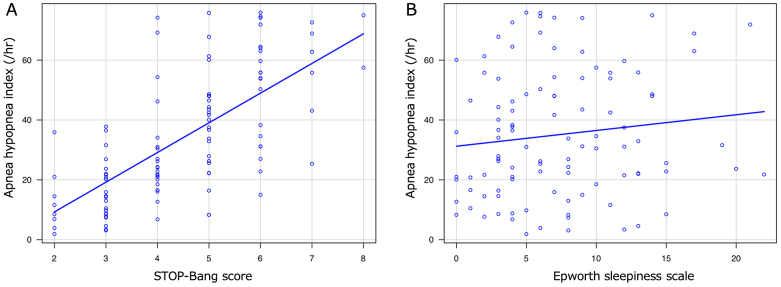
The correlation between the apnea hypopnea index (AHI) and the STOP-Bang test (A) or Epworth sleepiness scale (B). The correlation coefficients between the STOP-Bang score or ESS and AHI were 0.701 (P < 0.001) and 0.137 (P = 0.17), respectively.